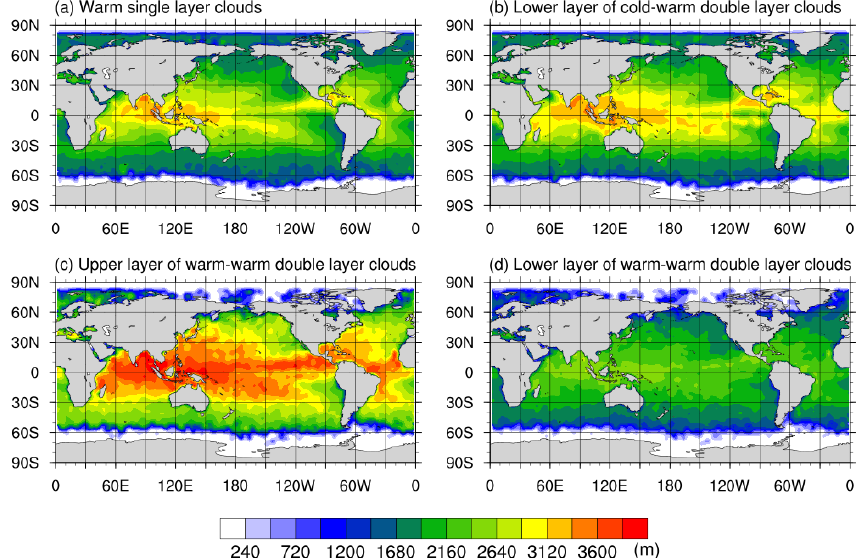
Figure 6. Global distribution of cloud top height for warm single layer clouds ( a ), lower layer of cold-warm double layer clouds ( b ), upper layer of warm-warm double layer clouds ( c ), and lower layer of warm-warm double layer clouds ( d ).